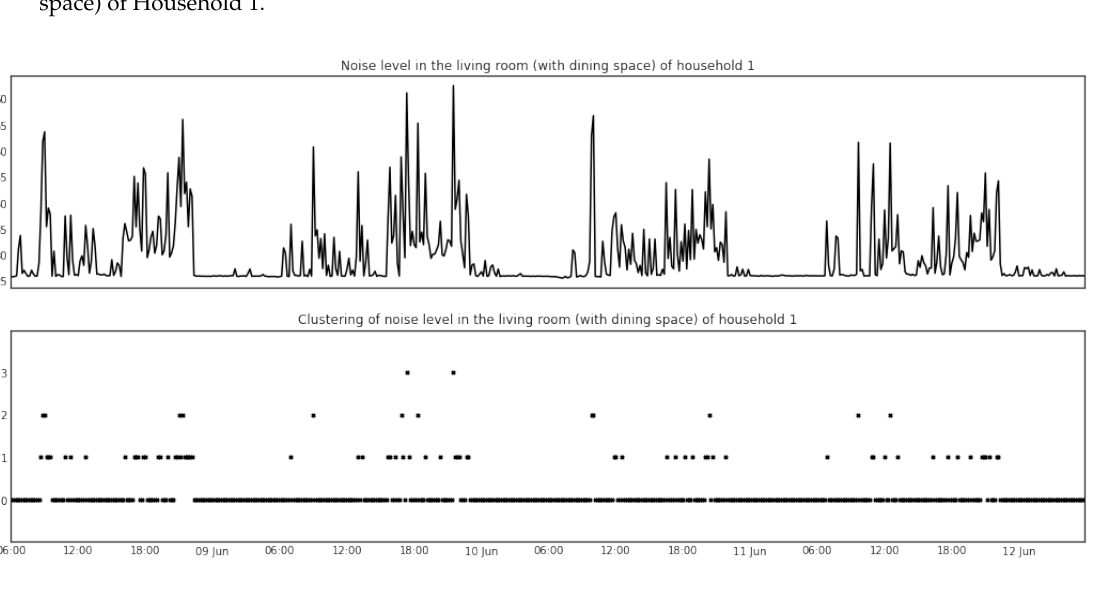
Figure 3. Mean shift clustering of range readings from a sensor box in the living room (with dining space) of Household 1.